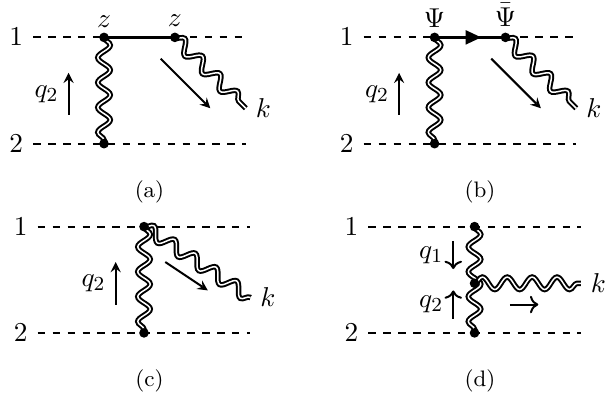
Figure 4 . Topologies contributing to the leading-order gravitational radiation for spinning worldlines. For diagrams 4b, we also need to include the crossed diagrams that can be obtained by simply reversing the arrows on the worldline. For 4a–4c, we also need to include diagrams with 1 and 2